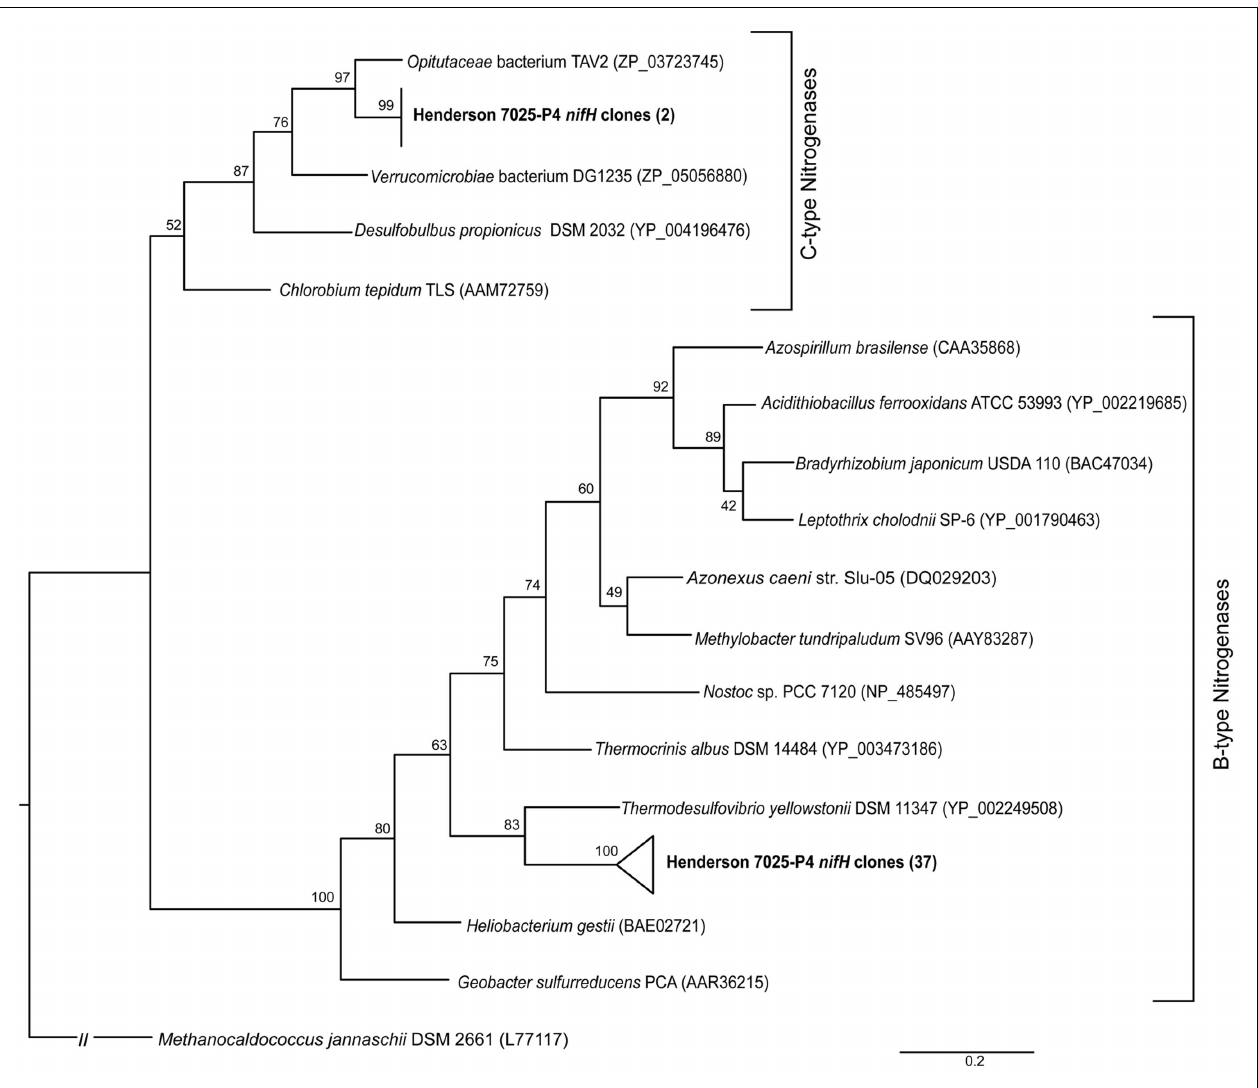
rRNA sequence. Two phylotypes were detected in 7025-P4, and they group with either the B- or C-type nitrogenases. Bootstrap values are shown, and the scale bar represents 0.2 substitutions per site.The tree was constructed using an archaeal nifH sequence as an